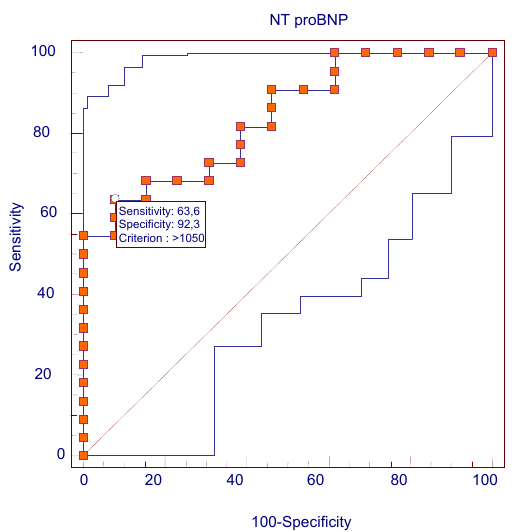
Fig. 1. ROC-curve for prediction of AF in STEMI patients using NT proBNP level